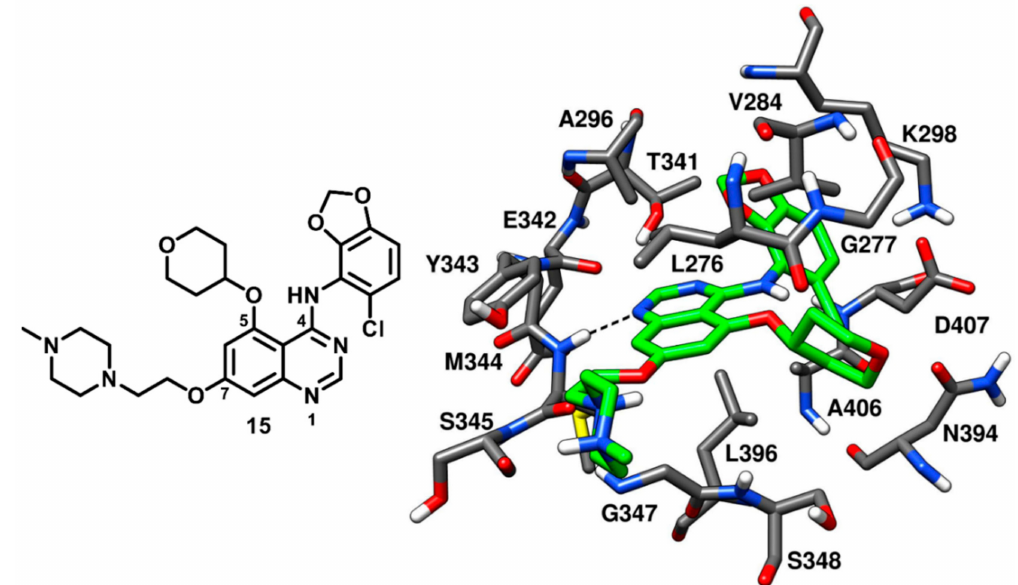
Figure 15. 2D structure of 15 and X-ray structure of c-Src kinase in complex with 15 (PDB ID: 2H8H). Active site residues of c-Src kinase and the enzyme–inhibitor H-bond interactions are